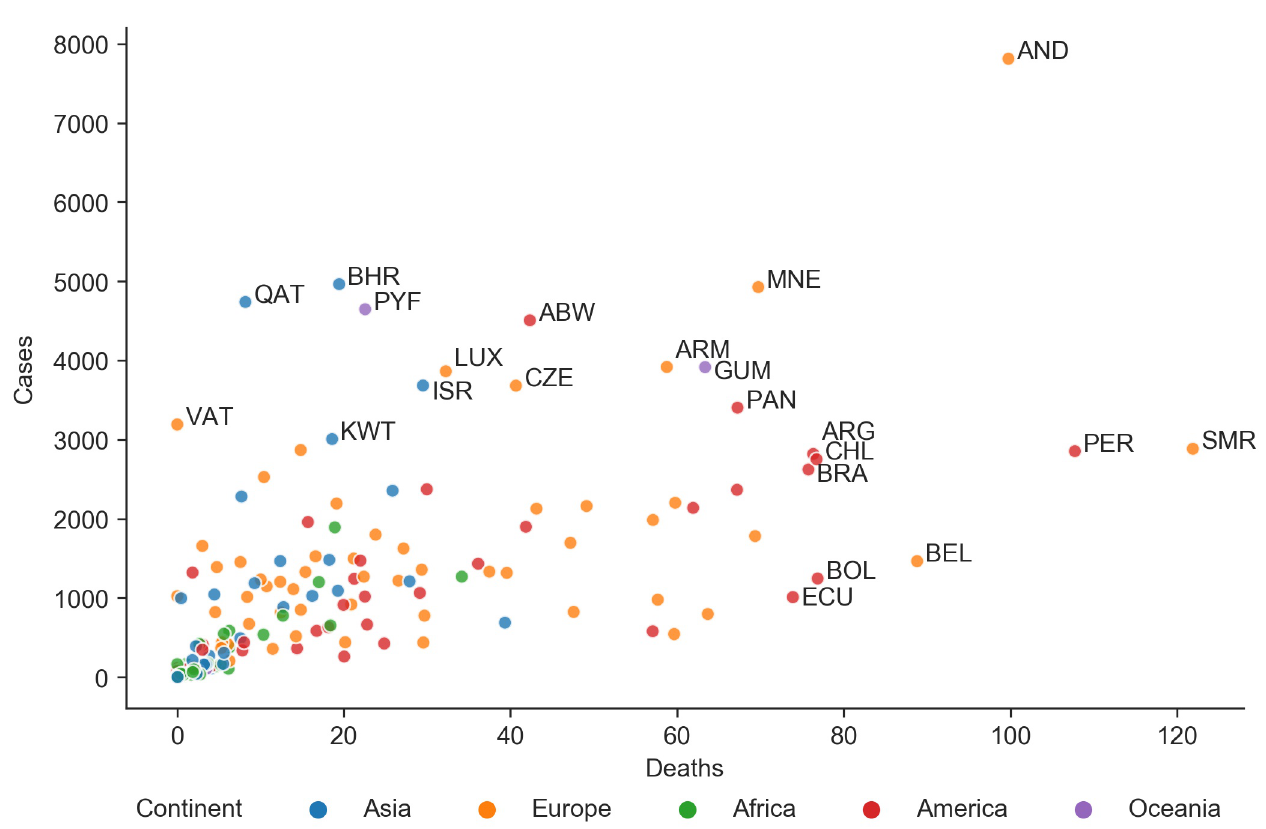
and deaths was found to be positive (0.67), as expected. Figure 15. Cases vs. deaths: Accumulated deaths vs. cases (per 100,000 of the population) in the different countries